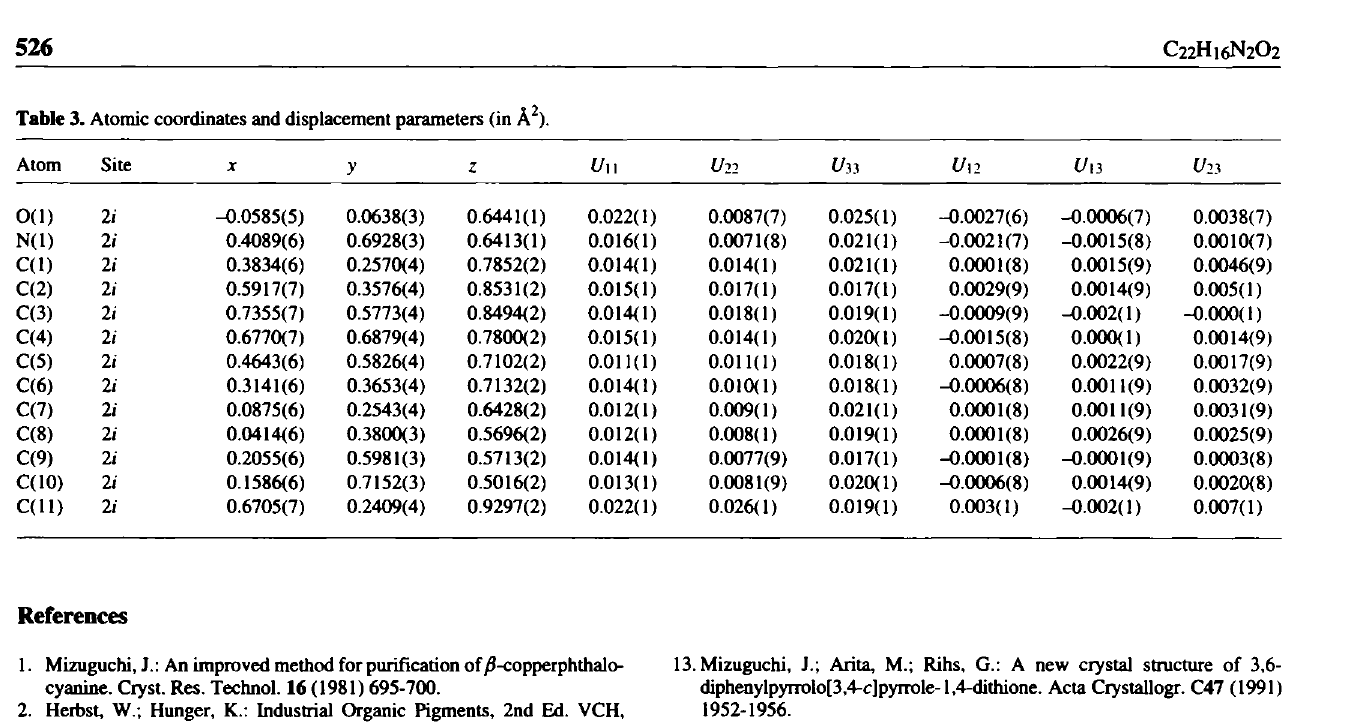
Table 3. Atomic coordinates and displacement parameters (in Â 2